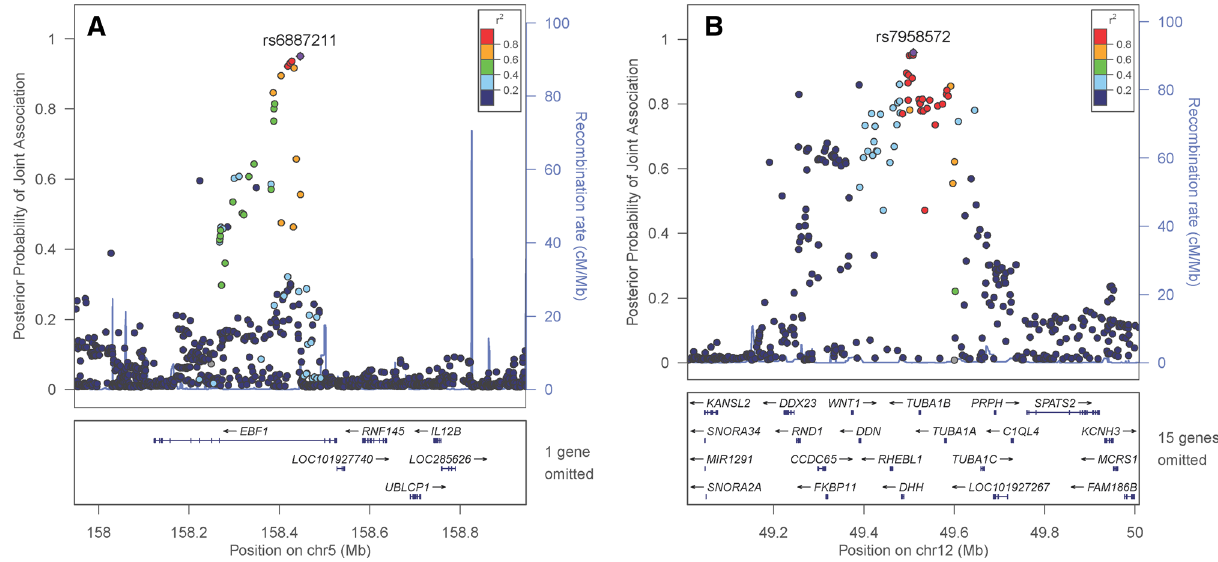
Figure 2. Regional plots of novel pleiotropic loci associated with birthweight and childhood obesity traits. ( A ) rs6887211 ( EBF1 ) locus association with both birth weight and childhood body mass index ( B ) rs7958572 ( LMRB1L ) locus associated with both birthweight and childhood obesity or childhood body mass index. The horizontal axes cover a region 500 kb upstream and downstream from the reference SNP. The vertical axes denote the joint association probabilities of the SNPs with both birthweight and childhood obesity traits. The purple triangles denote the index SNPs (rs6887211 in EBF1 and rs7958572 in LMRB1L ). All other colored points denote the surrounding SNPs in that region, and they are colored based on their linkage disequilibrium (r 2 ) with the reference SNP. The box at the bottom shows genes that fall in the